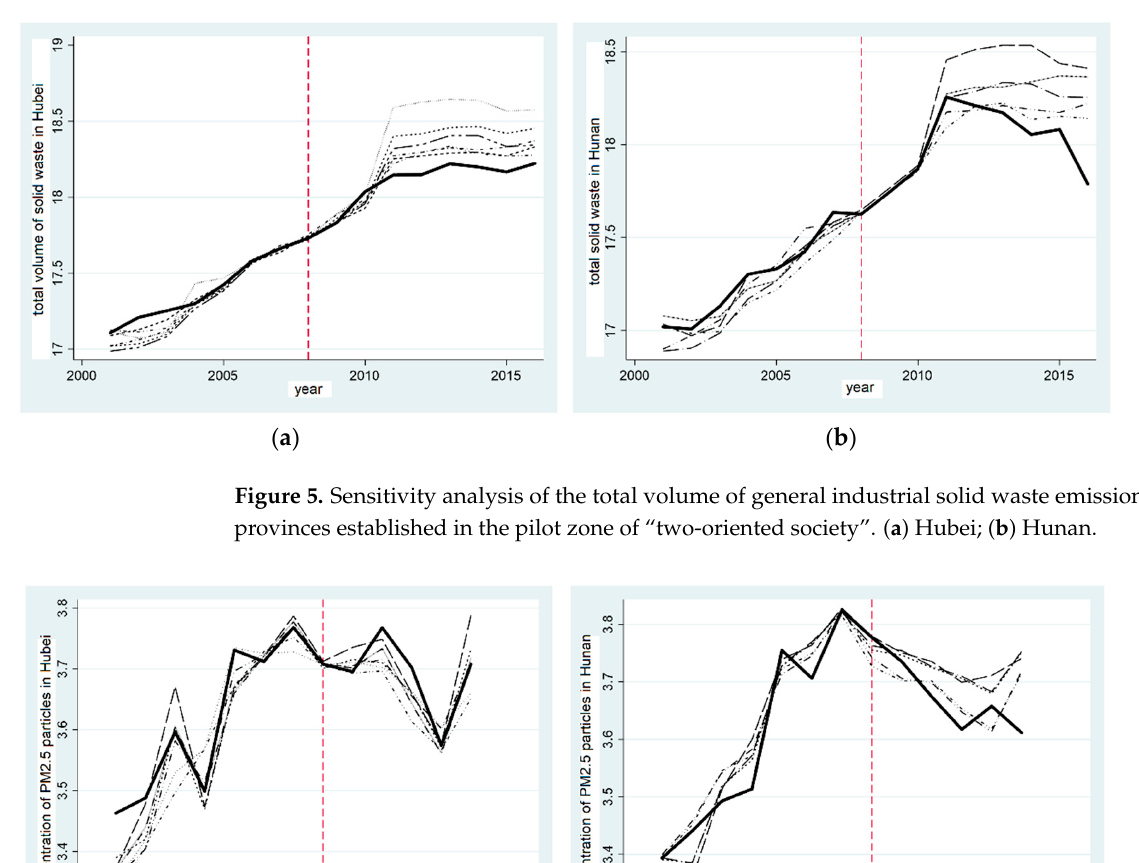
Figure 5. Sensitivity analysis of the total volume of general industrial solid waste emissions in the provinces established in the pilot zone of “two-oriented society”. ( a ) Hubei; ( b ) Hunan.